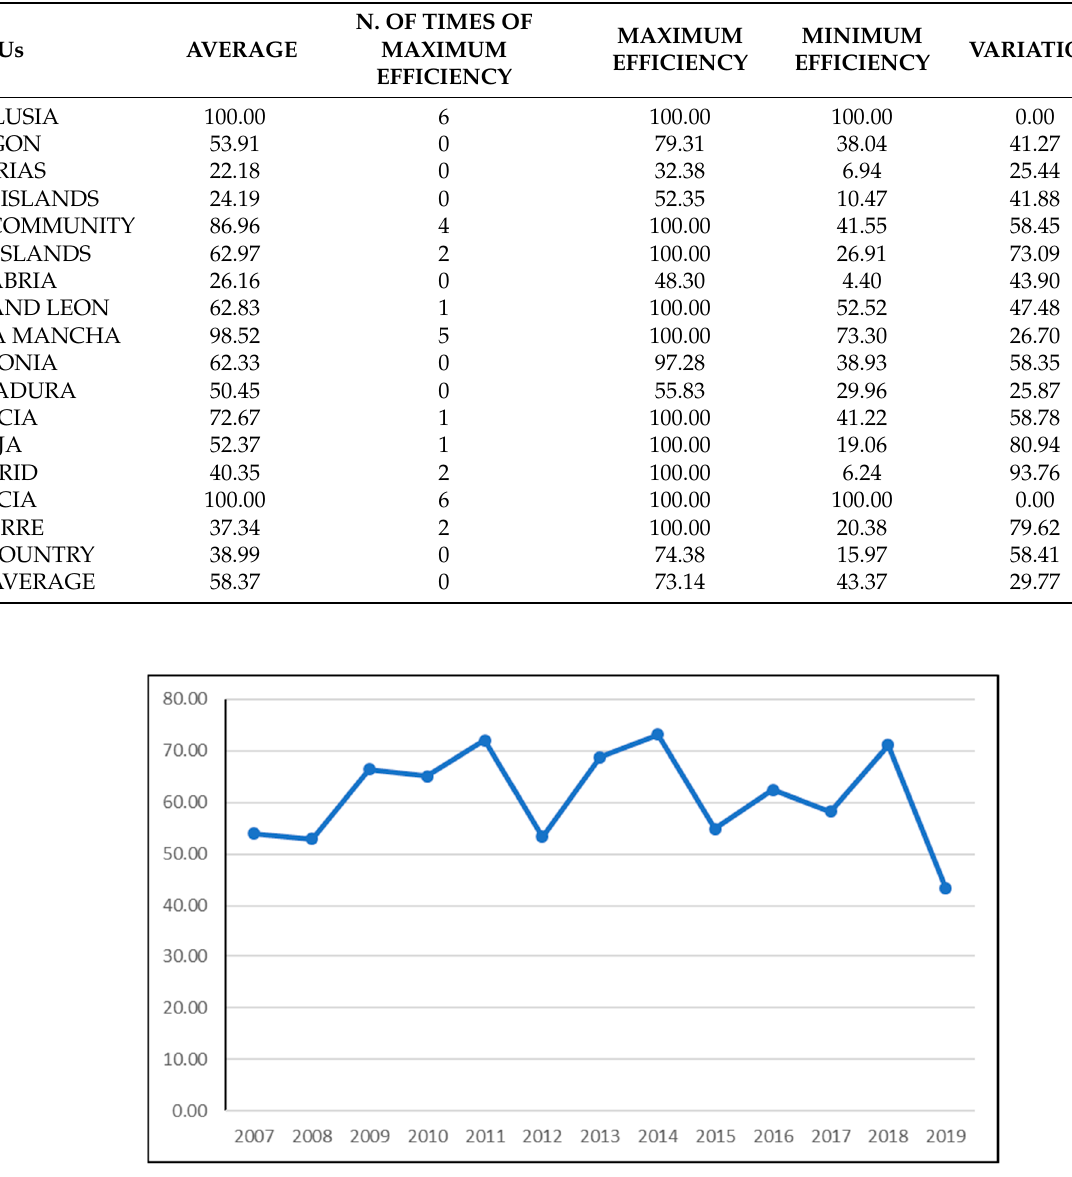
Figure 7. Evolution of the level of efficiency (Spanish average) period 2007–2019 (Source: Own elaboration).